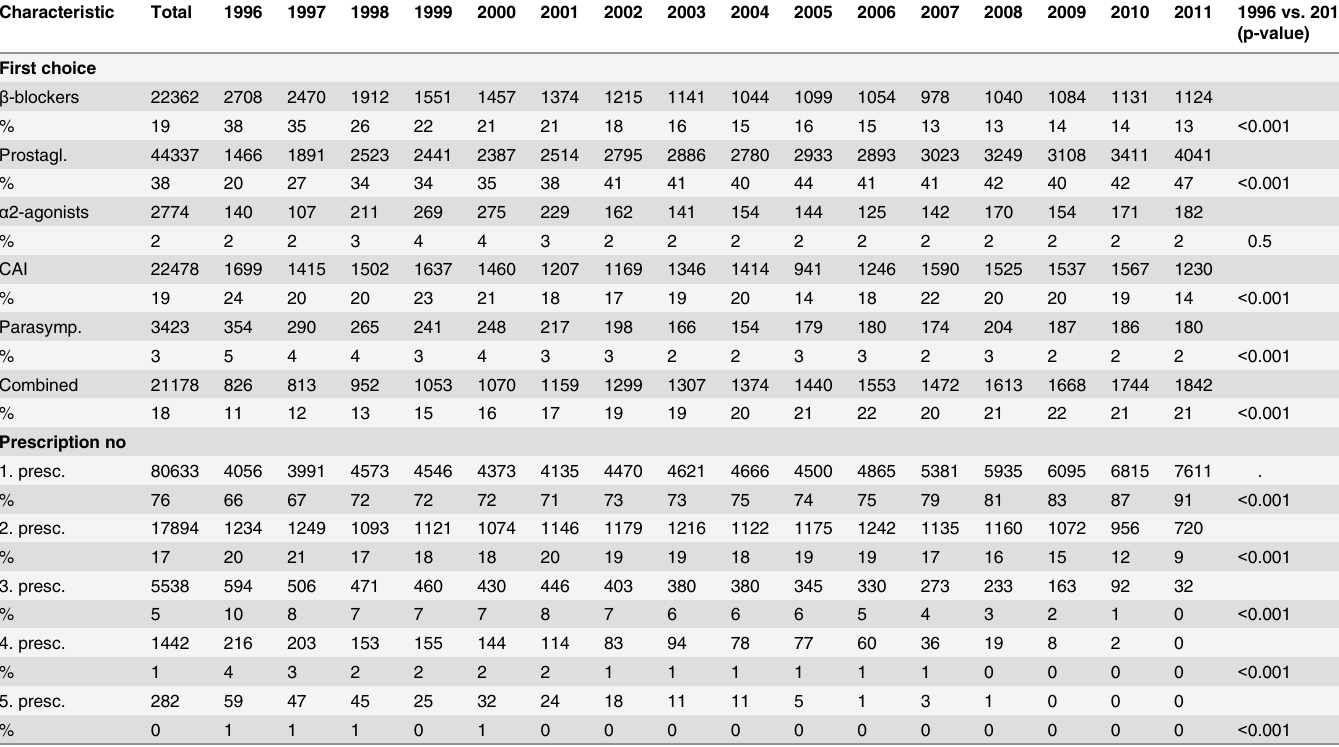
Table 4. Baseline characteristics of glaucoma medication in the Danish population in the period from 1996 to 2011. Characteristic